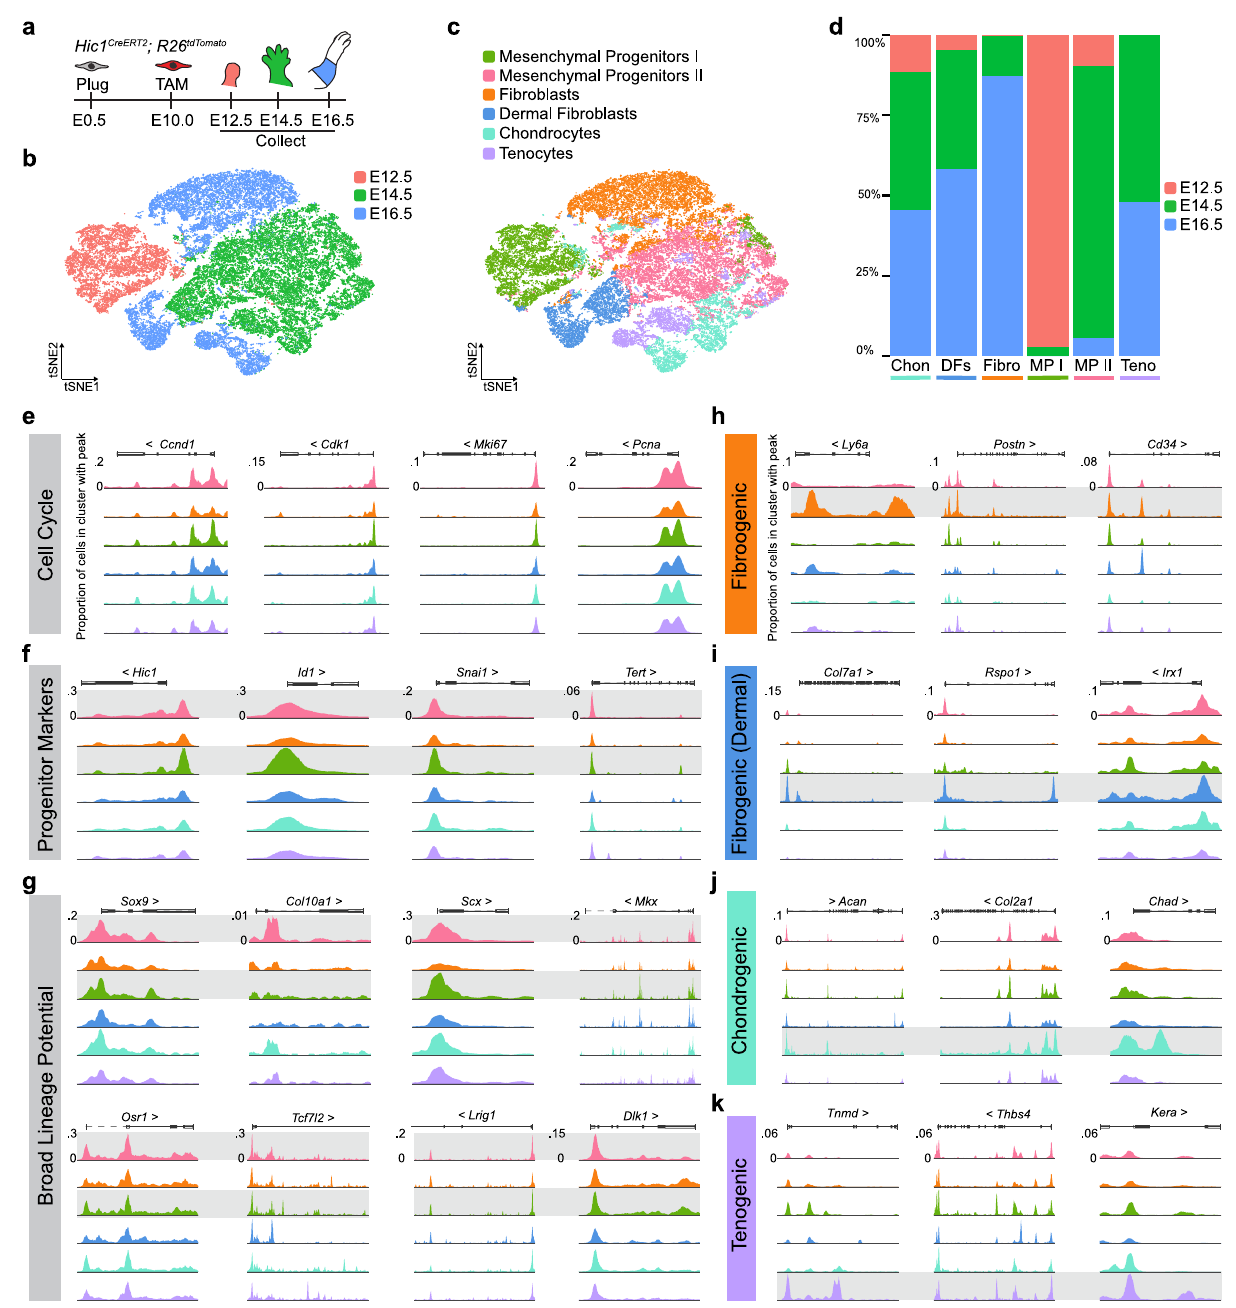
Fig.5|Broadmesenchymallineagepotentialisembeddedintheepigenomeof early tdTomato + MPs. a Schematic of Hic1 CreERT2 ; R26 tdTomato sample collection for scATAC-seq. b t-SNE plot of aggregated scATAC-seq data from sorted tdTomato + MPs coloured according to embryonic timepoint. c t-SNE plot of aggregated scATAC-seq data from sorted tdTomato + MPs coloured according to cluster iden- tity. d Stackedbargraphillustratingthecompositionofeachclusterwithrespectto embryo timepoints. e – k Genome browser tracks from scATAC-seq analyses